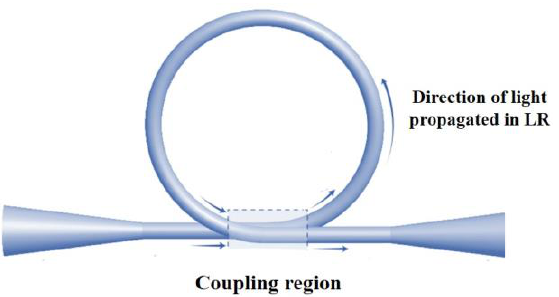
Figure 17. Schematic of loop resonator (LR) while arrows represent the direction of light propagated in LR.